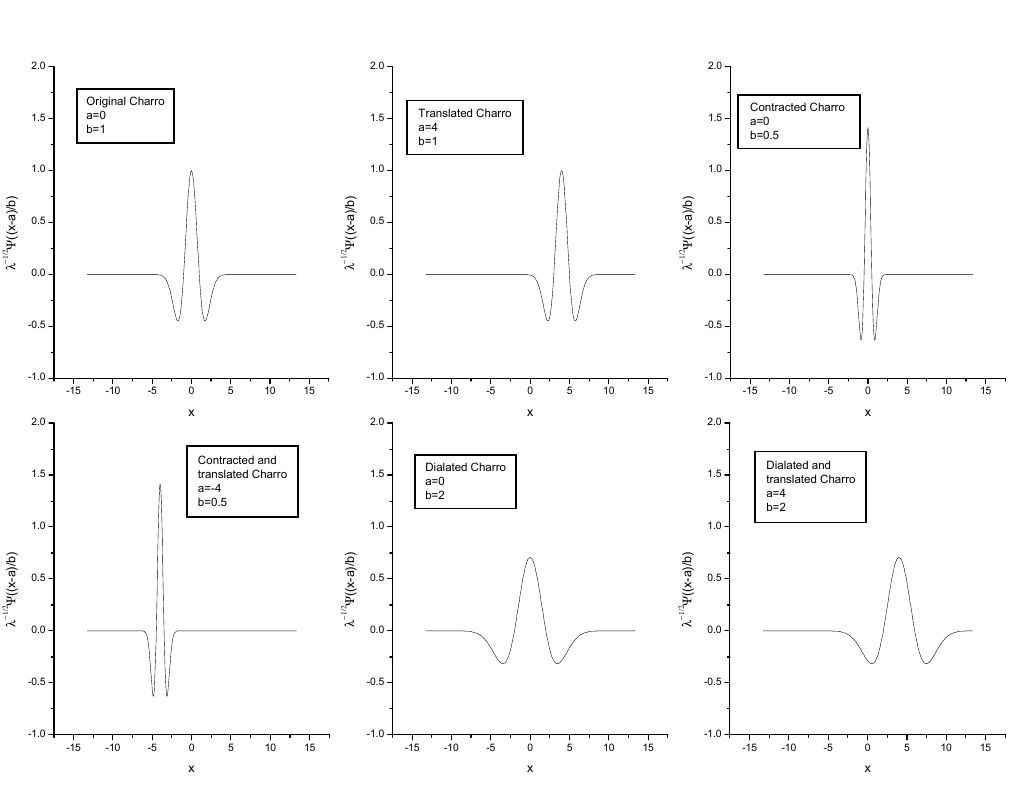
Figure 116: Some examples of Mexican Hat wavelet, for different values of the parameters 𝜏 and 𝑡 ′ .